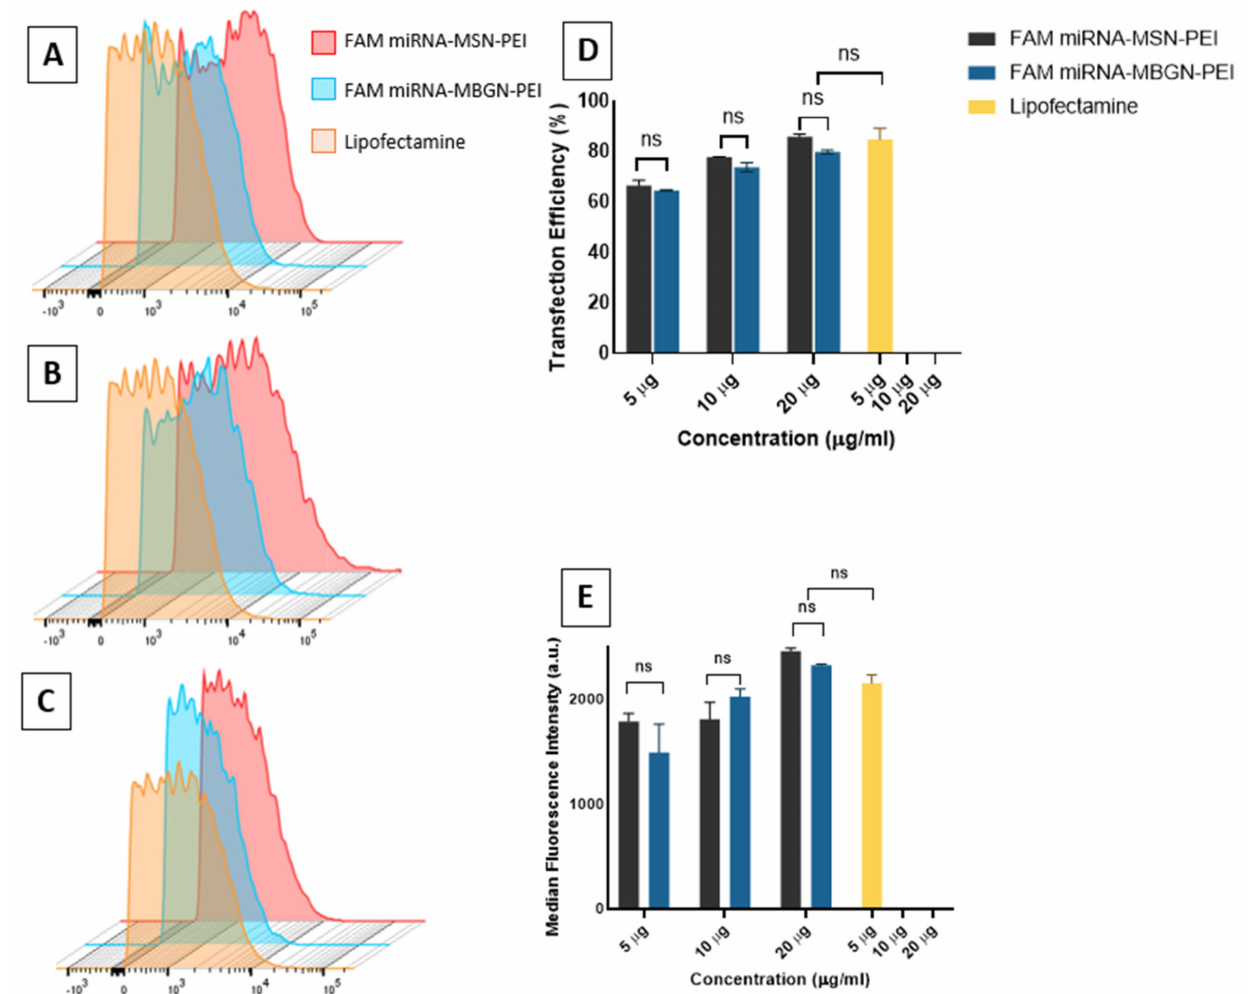
Figure 6. Transfection efficacy of FAM labelled microRNAs by MSN-PEI or MBGN-PEI towards rBMSCs. Stacked histogram of relative fluorescence intensity ( A – C ) of rBMSCs after transfection with FAM labelled microRNAs for six hours. The percentage of transfection efficiency ( D ) and the mean fluorescent intensity ( E ) ( n = 3) were quantified with flow cytometry. Results are shown as mean ± SD. ns means there was no significant difference by post hoc Tukey tests ( n =